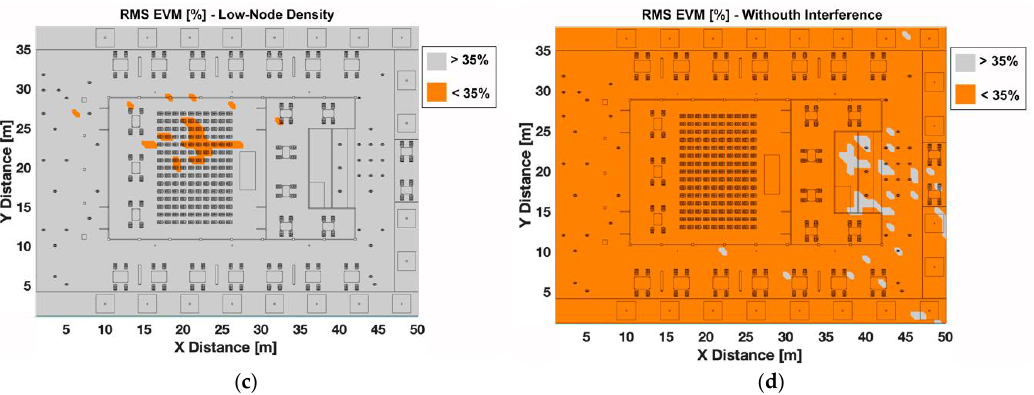
Figure 10. EVM (%) for the considered scenario for O-QPSK modulation when indoor node is transmitting, ( a ) high-node density scenario, ( b ) medium-node density scenario, ( c ) low-node density scenario, and ( d ) without interference.